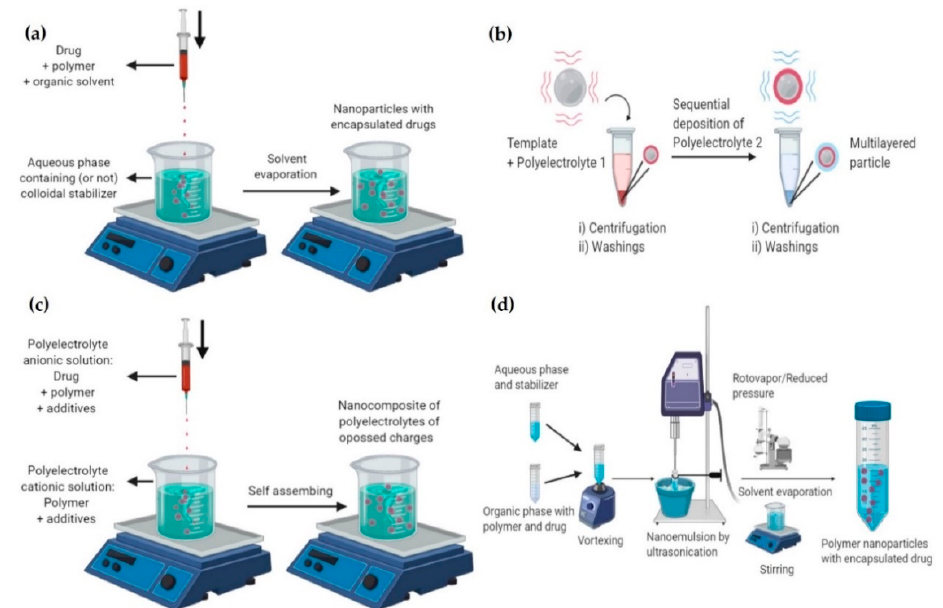
Figure 3. Manufacturing PNs by conventional methods. ( a ) Nanoprecipitation. The polymer dissolved in the organic solvent is added to an aqueous solution by dripping under constant stirring, forming the PNs instantly. ( b ) Layer-by-layer assembly. The solid form of the active principle is used as the core and the respective layers are formed on top, one by one, according to the electric charge. ( c ) Ionic gelation method. Self-assembling of polyelectrolytes by electrostatic interactions forming polyelectrolytic complexes. ( d ) Emulsion evaporation method. After nanoemulsion formation, the solvent evaporates gradually under reduced pressure or stirring to produce polymeric nanoparticles.